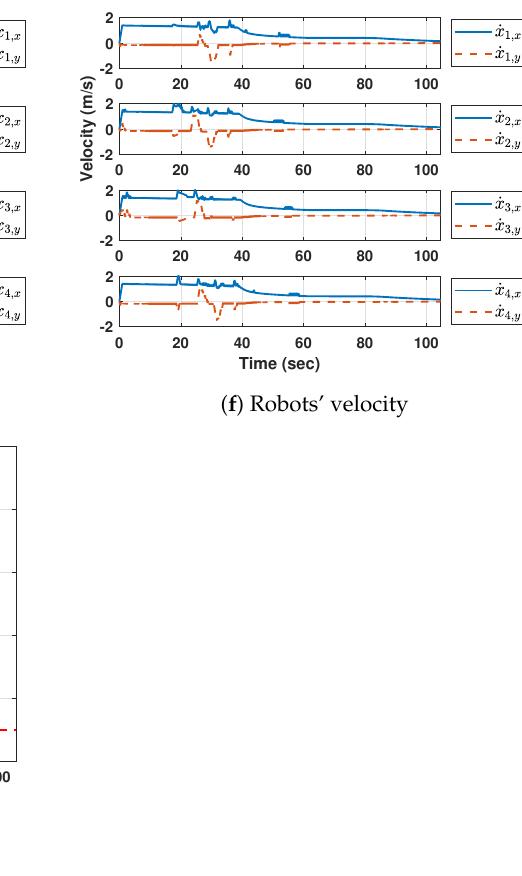
Figure 13. Testing results: Case